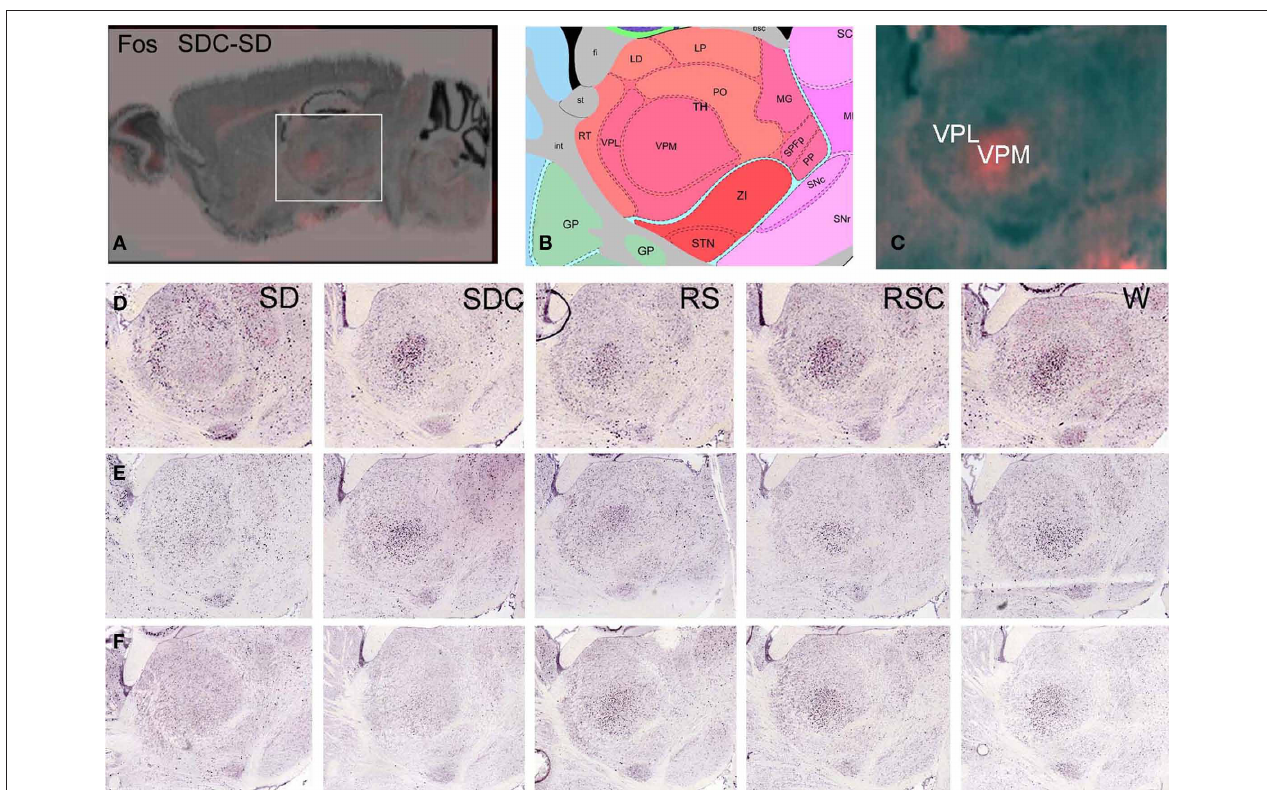
Figure 3 | Difference grid analysis identified decreased Fos expression in the ventral posteromedial nucleus of the thalamus during SD. Difference grid representation of upregulated Fos expression in SDC versus SD, showing higher expression (orange) in SDC than SD in VPM at low magnification (A) and